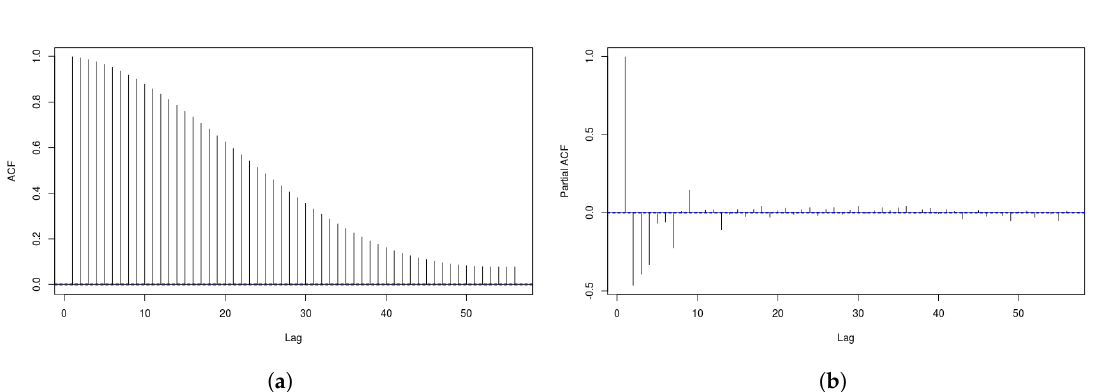
Figure 1. Correlation plots for the original time-series. ( a ) AutoCorrelation Function (ACF); ( b ) Partial AutoCorrelation Function (PACF).